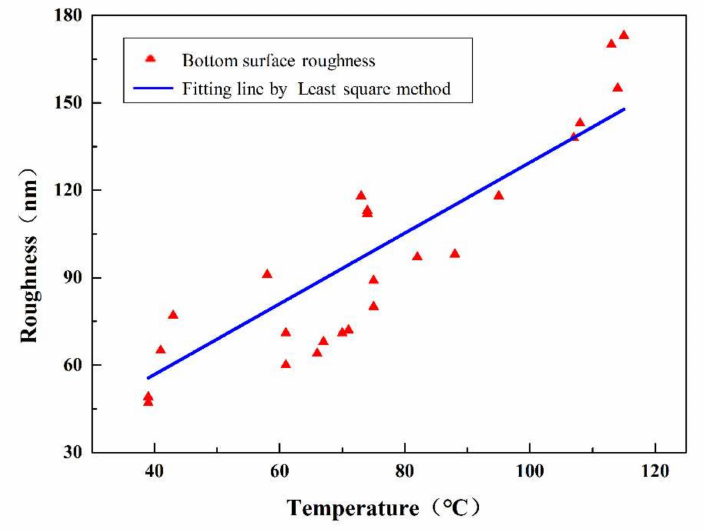
Figure 5. Relationship between processing temperature and groove surface roughness. (The temperature was measured during the micro milling experiments with the parameters in Table 1 by the infrared camera (IGA 6 Advanced, Lumasense Technologies Co., Stockholm,